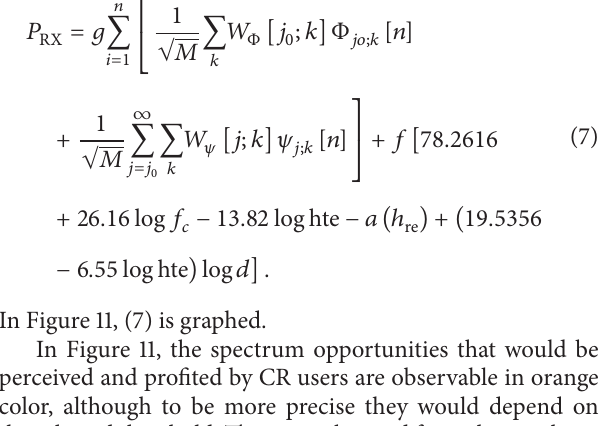
Figure 4: Adjusted and received power for H-O model of the GSM channel. Table 3: Error variables for the received power forecasts in the GSM channel, based on the wavelet neural model. SMAPE MAPE MAE GSM channel 0.0019 0.0010